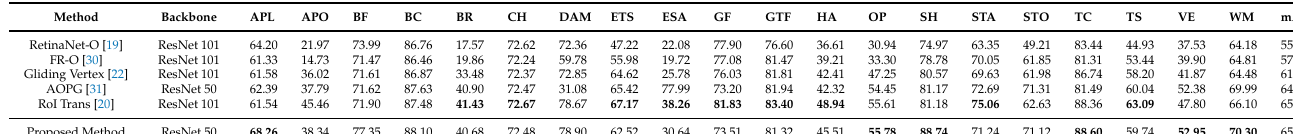
Table 2. Comparisons with state-of-the-art methods on DIOR-R dataset test set. Bold denotes the best detection results.